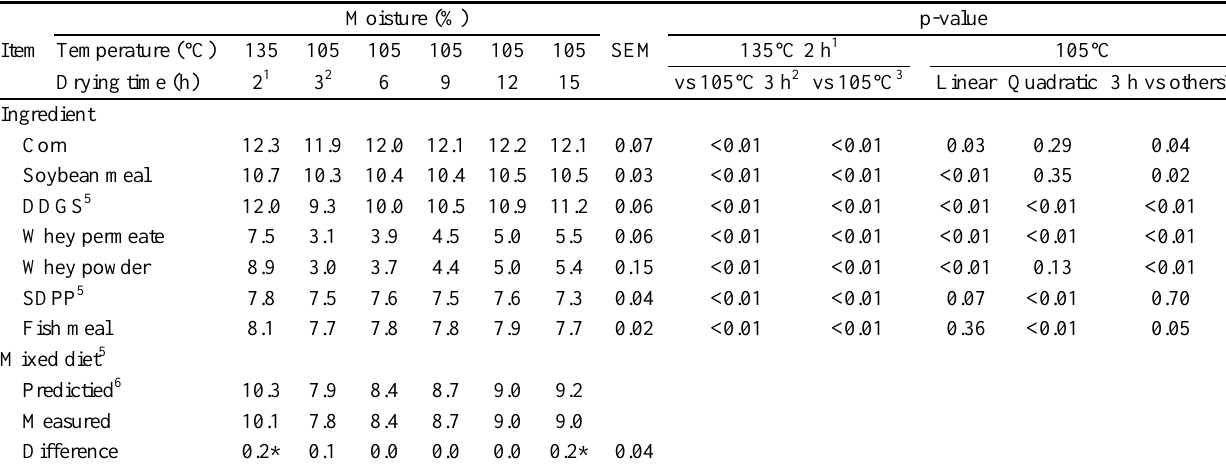
Table 1. Moisture concentrations in feed ingredients and a mixed diet determined by various oven-drying methods (Exp. 1)